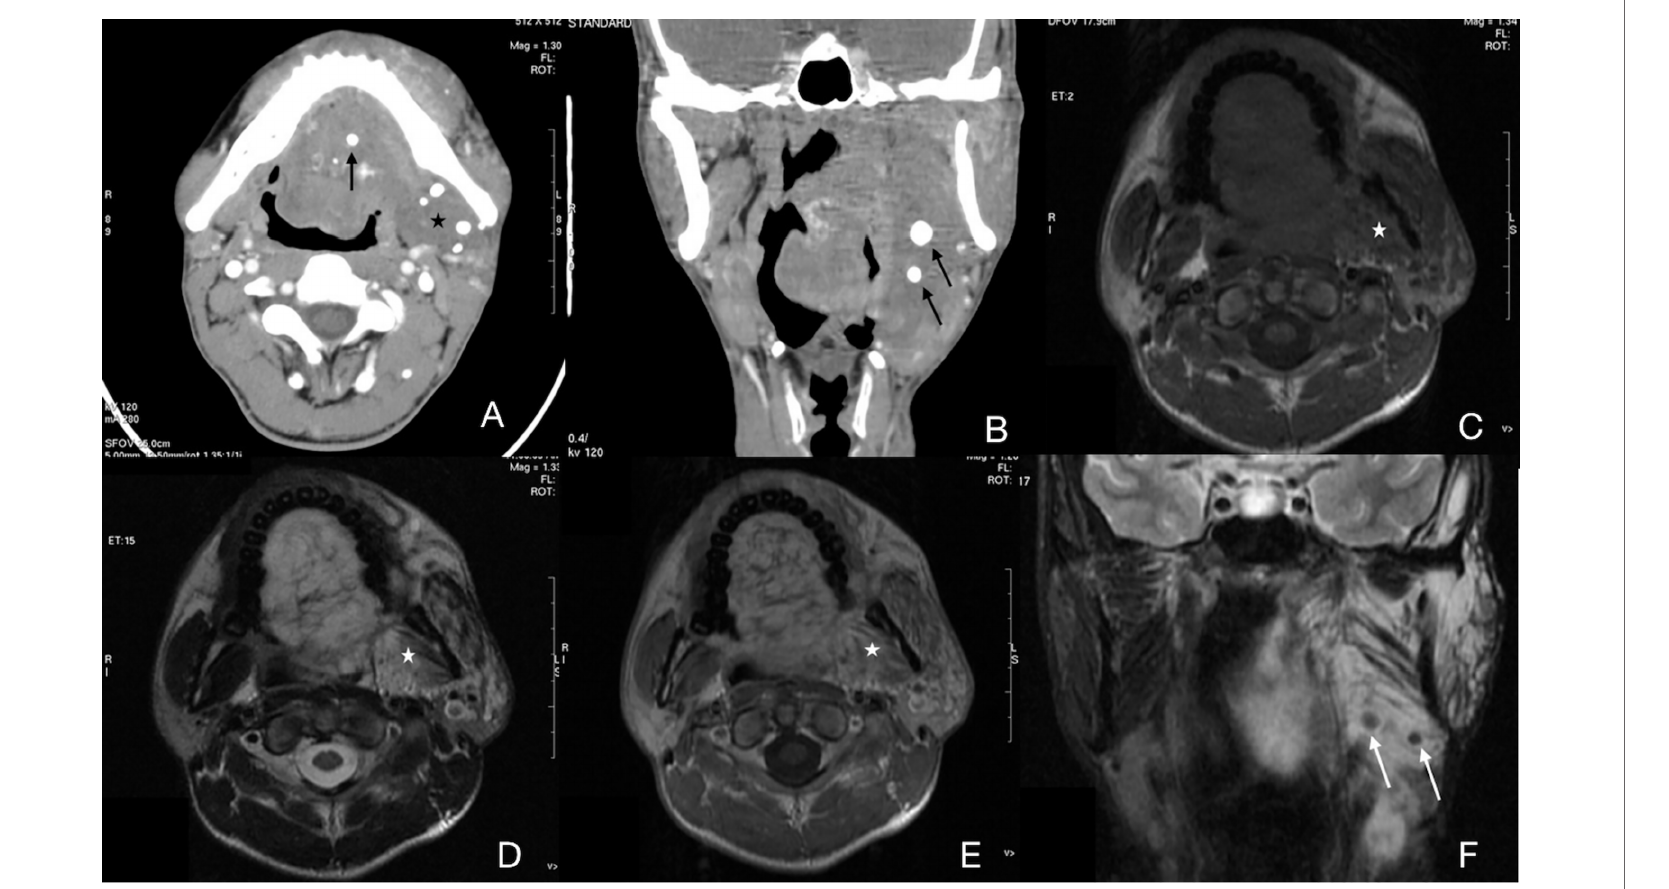
FIGURE 3 | Case 13 ( Supplementary Table 1 ), cavernous IMHs. (A) Axial CT image showing multiple phleboliths (arrow) in a diffuse, hypo attenuated lesion (star). Oral fl oor and left masticatory muscles were in fi ltrated. (B) Coronal CT image showing multiple phleboliths (arrow). (C) Axial T1WI showing a diffuse, intermediate signal-intensity lesion with a vague border (star). (D) Axial T2WI showing a lesion with slightly high signal intensity and a blurred border. (E) Axial enhanced T1WI showing no enhancement of the lesion (star). (F) Coronal enhanced fat-suppressed T1WI showing multiple round, low signal-intensity structures which indicated phleboliths